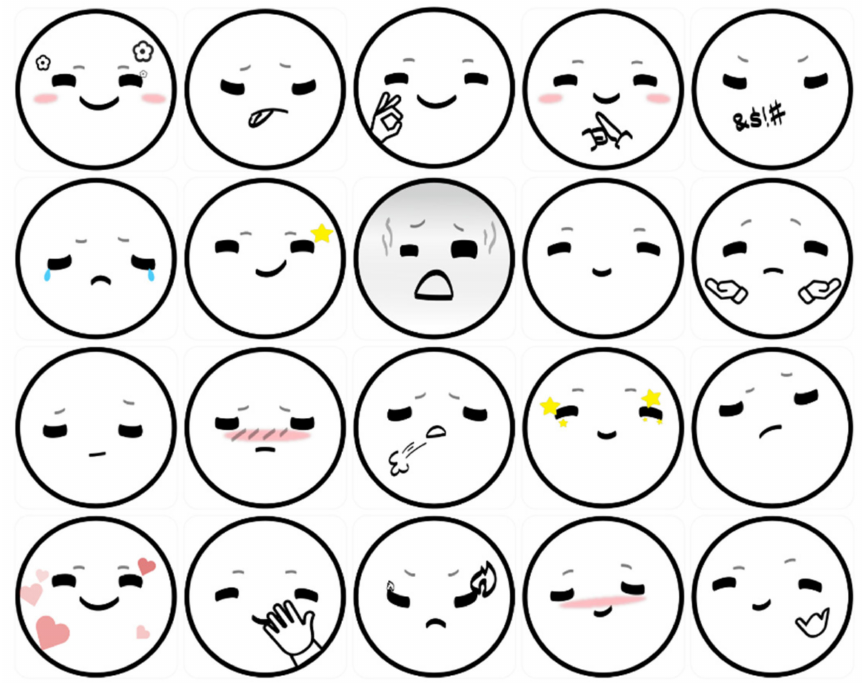
Figure 3. Iterative image design of 20 emotions. The emotions are, from left to right, top to bottom: happy-for, hate, satisfaction, gratitude, reproach, distress, pride, fear, mildness, pity, boredom, shame, disappointment, hope, resentment, love, gloating, anger, relief and